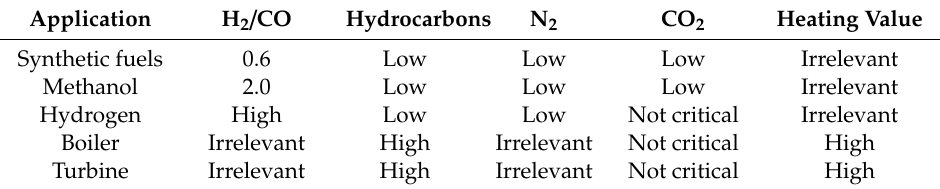
Table 8. Produced gas characteristic guidelines for di ff erent applications